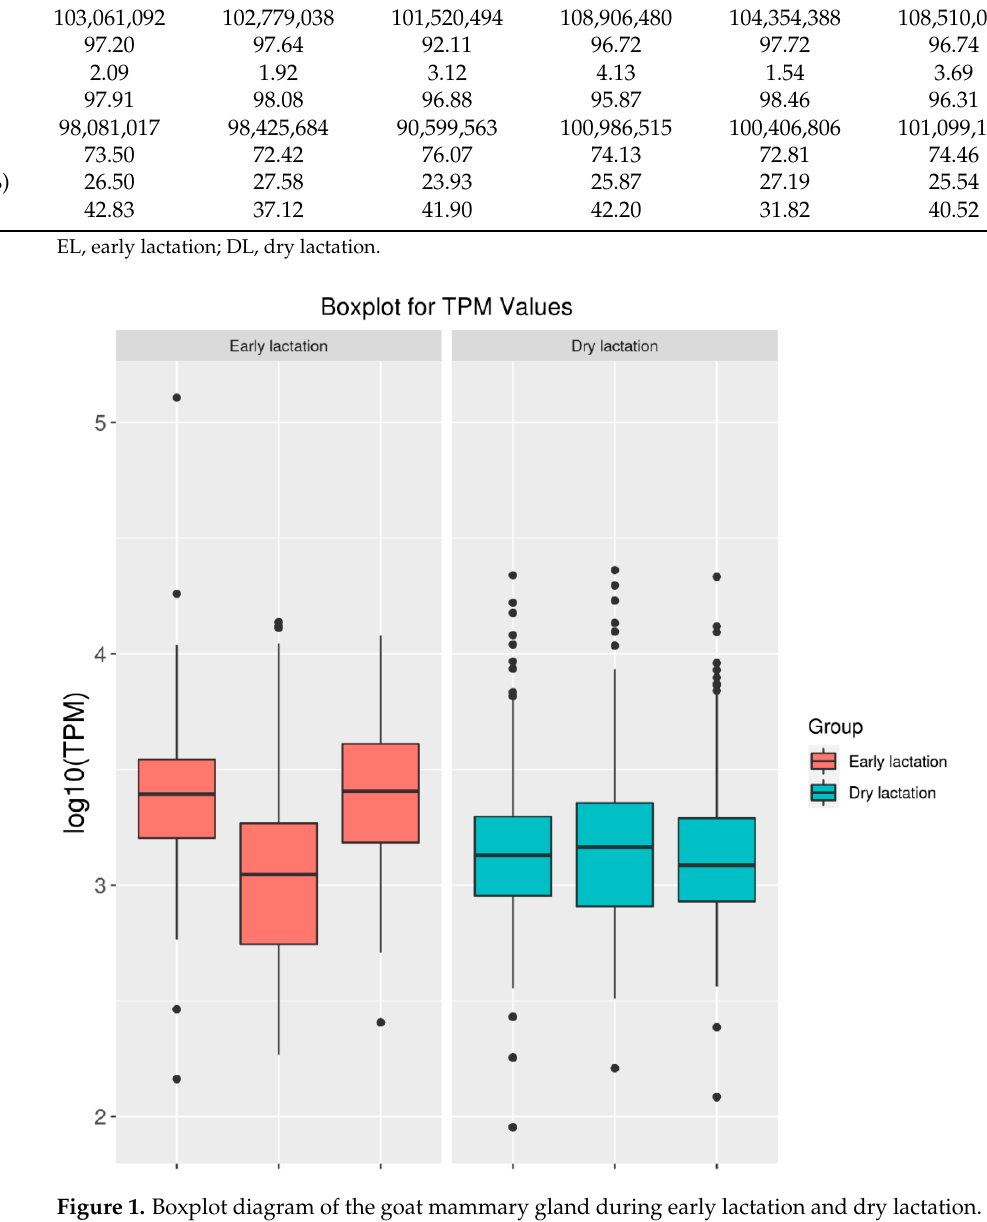
Figure 1. Boxplot diagram of the goat mammary gland during early lactation and dry lactation. TPM, transcripts per million.